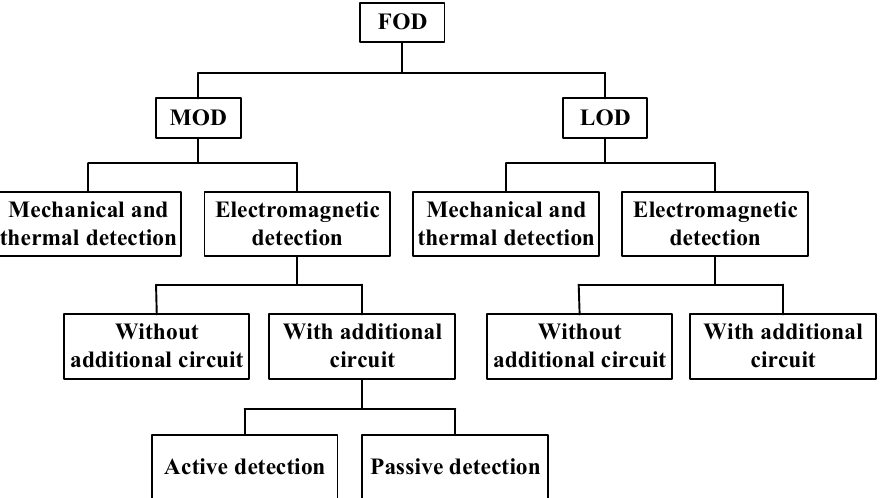
Figure 5. Categories of foreign object detection (FOD) methods.